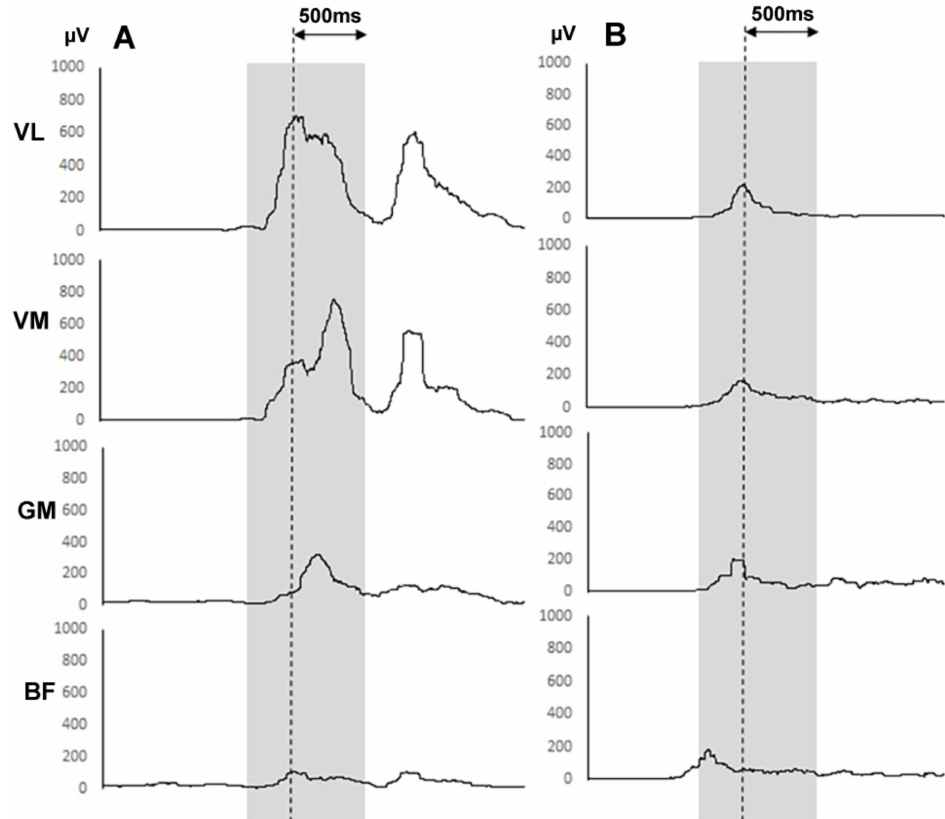
Figure 2. Processed EMG signals (RMS) and measurement periods for vastus lateralis (VL), vastus medialis (VM), gluteus medius (GM), and biceps femoris (BF) muscles during countermovement jump ( A ) and landing ( B